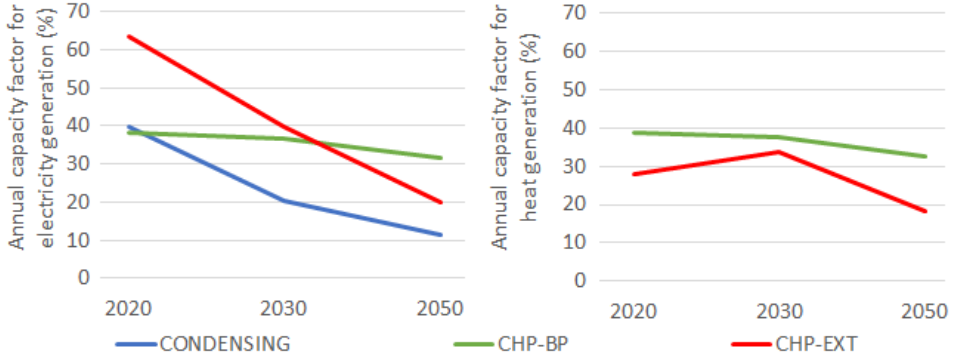
Figure 6. Average capacity factor development of thermal power units for electricity ( left ) and heat ( right ) generation using UC-MIP. The difference with NO-UC and UC-RMIP is negligible.